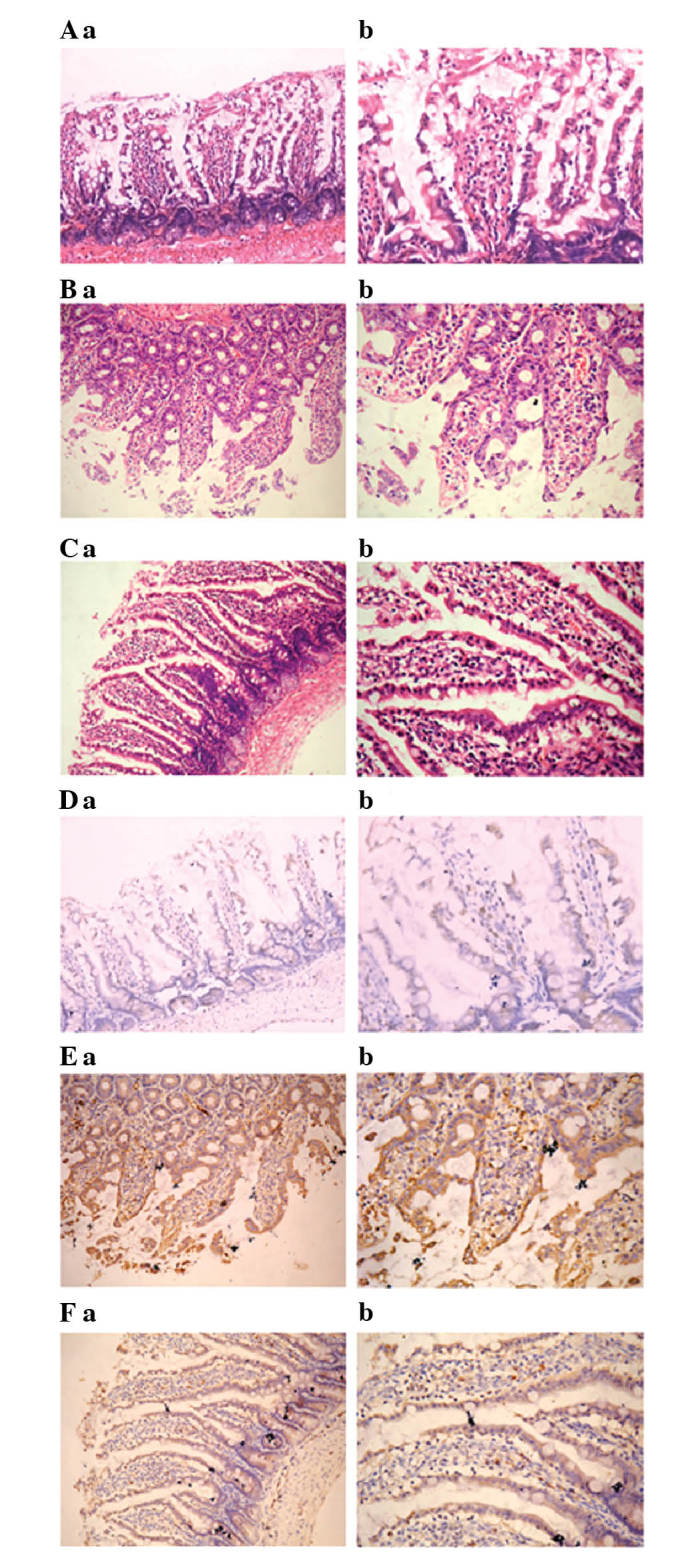
DADLE exerts a protective effect on rat intestinal tissues subjected to ischemia/reperfusion injury by inhibiting the expression of MKK7. Hematoxylin and eosin staining was performed to examine the appearances of the intesstinal tissues in the (A) control group, (B) model group and (C) DADLE-treated group. In the control group, the intestinal mucosal epithelium was intact, and no erosion or ulcers were observed. In the model group, detachment of the mucosa and erosion of the intestinal mucosal epithelium were observed. In the DADLE-treated group, the intestinal mucosal epithelium remained intact. The expression levels of MKK7 in the (D) control group, (E) model group and (F) DADLE-treated group were also examined. In the control group, MKK7 was not expressed at detectable levels. In the model group, marked expression levels of MKK7 were observed. In the DADLE-treatment group, the expression of MKK7 was also observed, although to a lesser extent compared with that in the model group. (Aa–Fa) magnification, ×100; (Ab–Fb) magnification, ×400. DADLE, (D-Ala2, D-Leu5)-enkephalin; Model, ischemia/reperfusion; MKK, mitogen-activated protein kinase kinase. Hematoxylin and eosin staining.